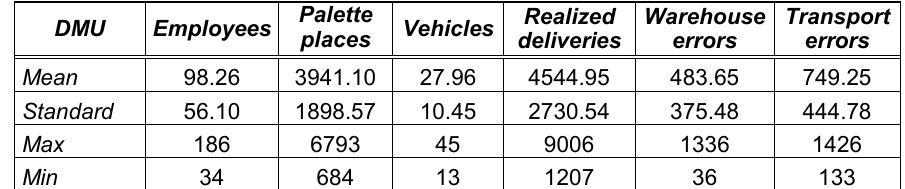
Inputs and output variables in